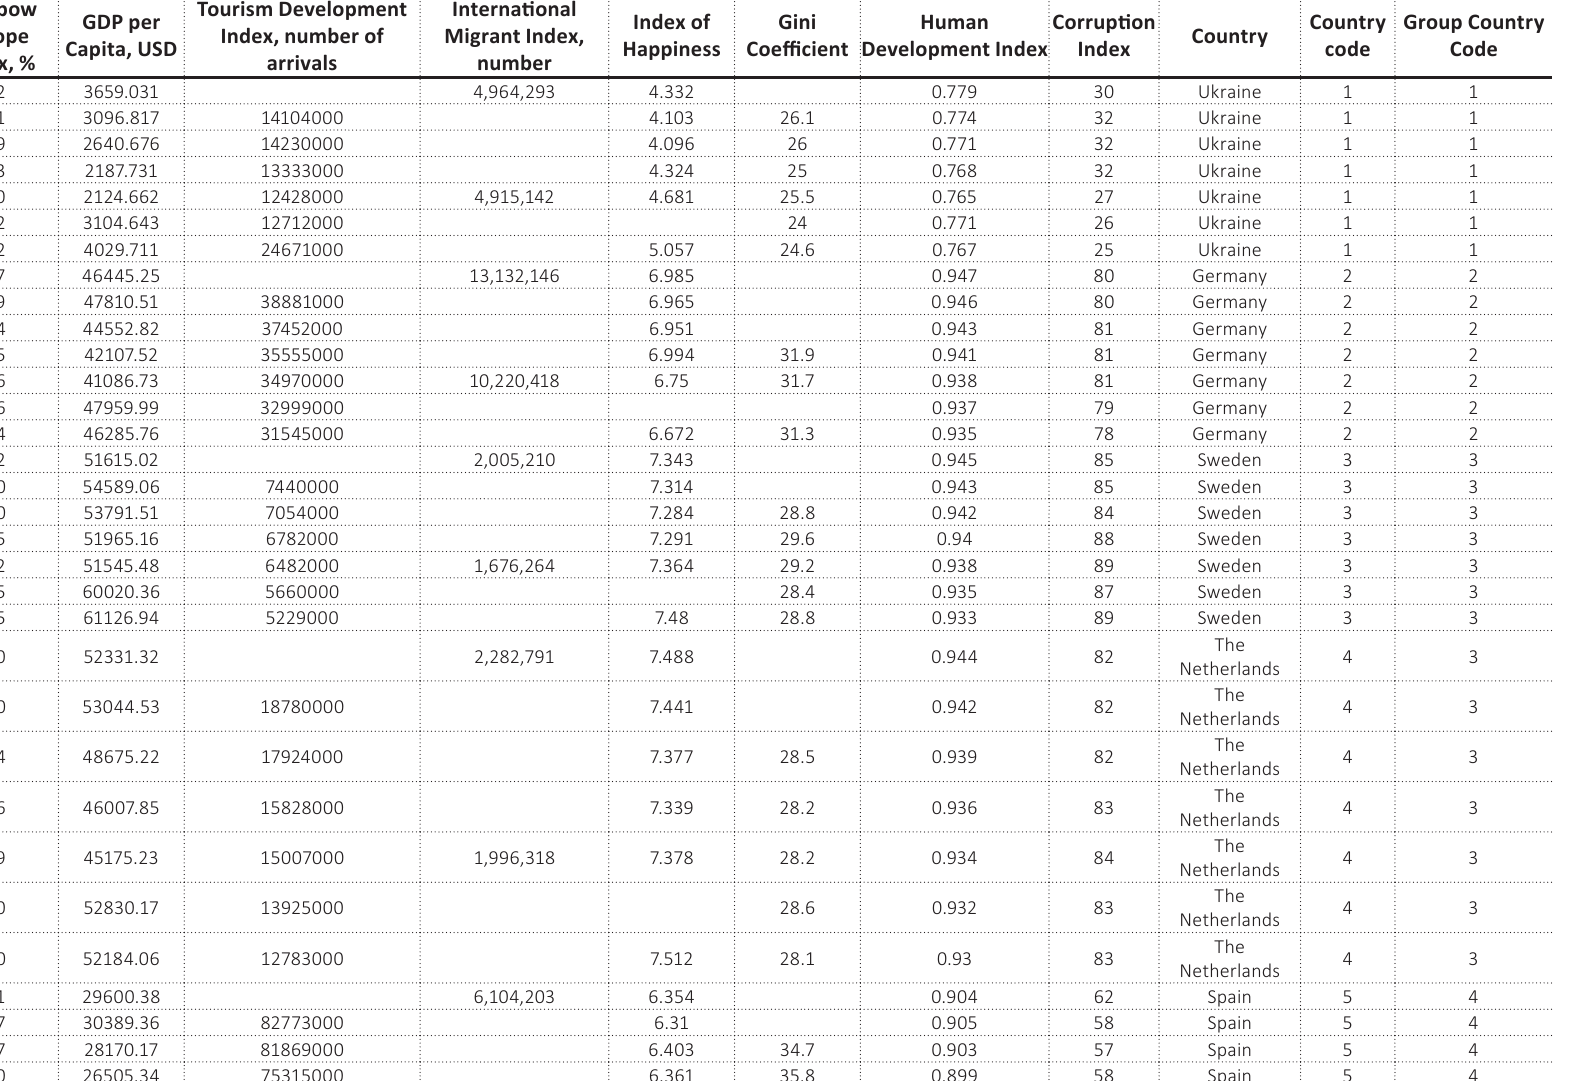
Table 2. Primary data and indicators for some European countries (The World Bank. (n.d.a), The World Bank. (n.d.b), The World Bank. (n.d.c)). Rainbow GDP per Year Europe Capita,